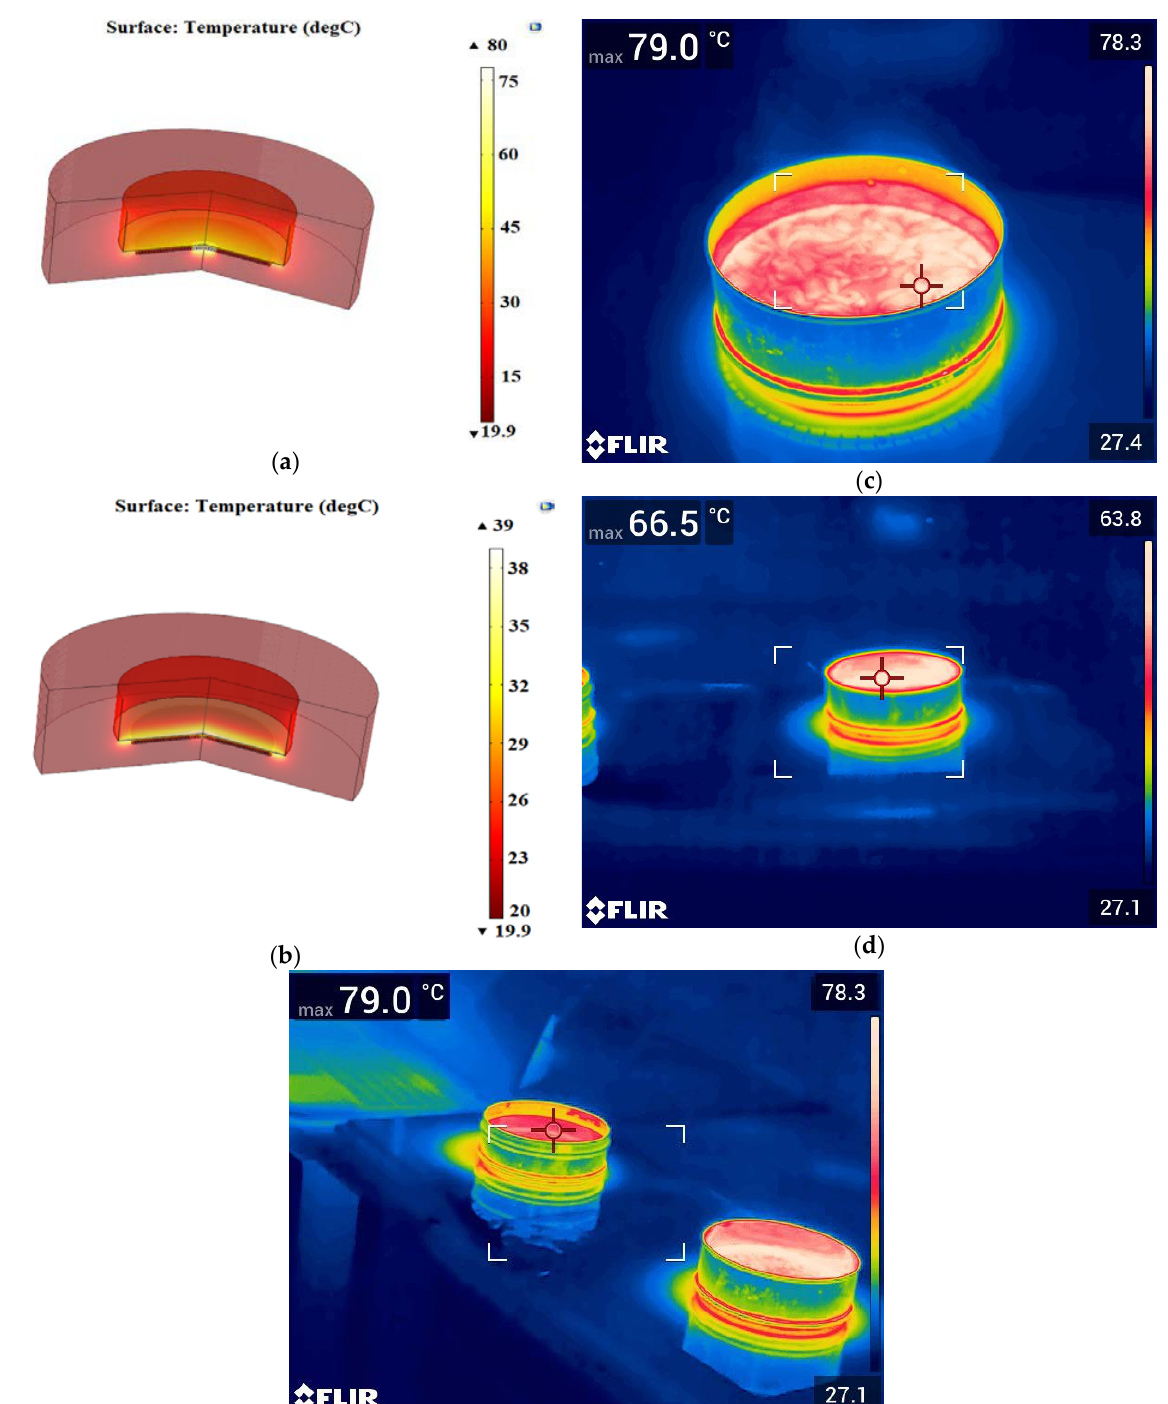
Figure 11. Simulated thermal image of ( a ) load 1 ( b ) load 2; experimental thermal image of ( c ) load 1, ( d ) load 2, ( e ) load 1 and load 2.